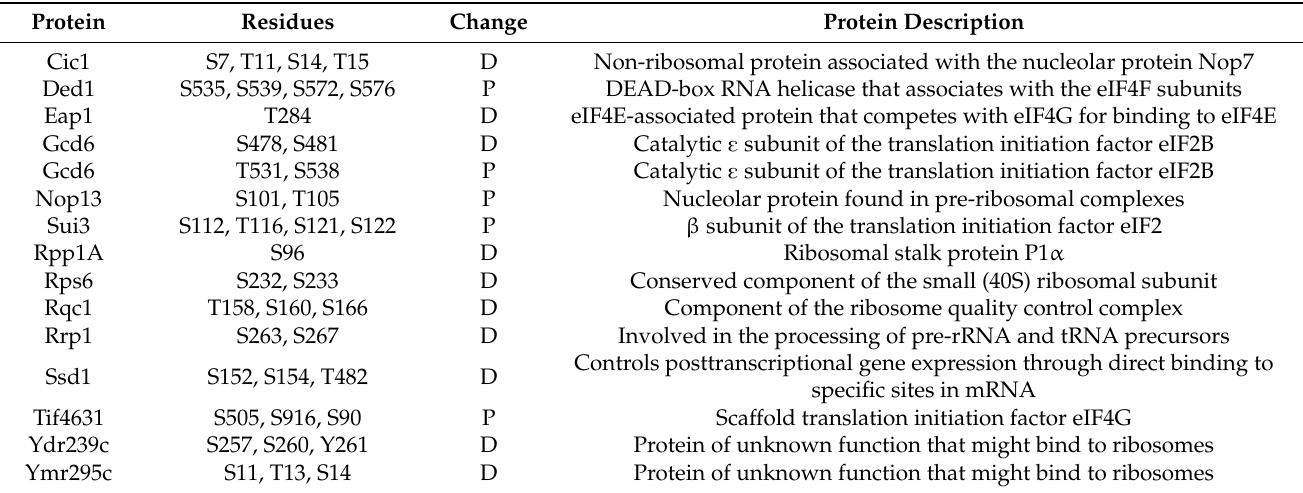
Table 1. Proteins involved in protein translation dephosphorylated and phosphorylated upon PPZ1 overexpression [29]. P, phosphorylated; D, dephosphorylated. Change Protein Description Non-ribosomal protein associated with the nucleolar protein